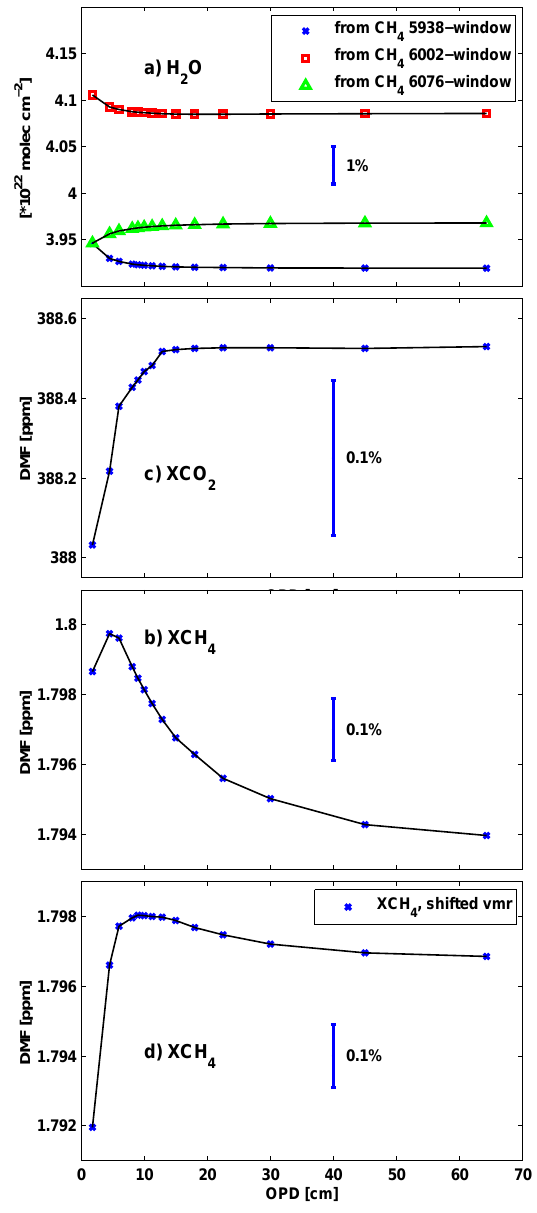
Fig. 11. Retrieved H 2 O, XCO 2 and XCH 4 from the IFS125HR, H 2 O is taken from the different retrieval windows of CH 4 . For XCH 4 the initial a-priori profile has been shifted vertically by − 4km. The shown bars give a percentage scale.